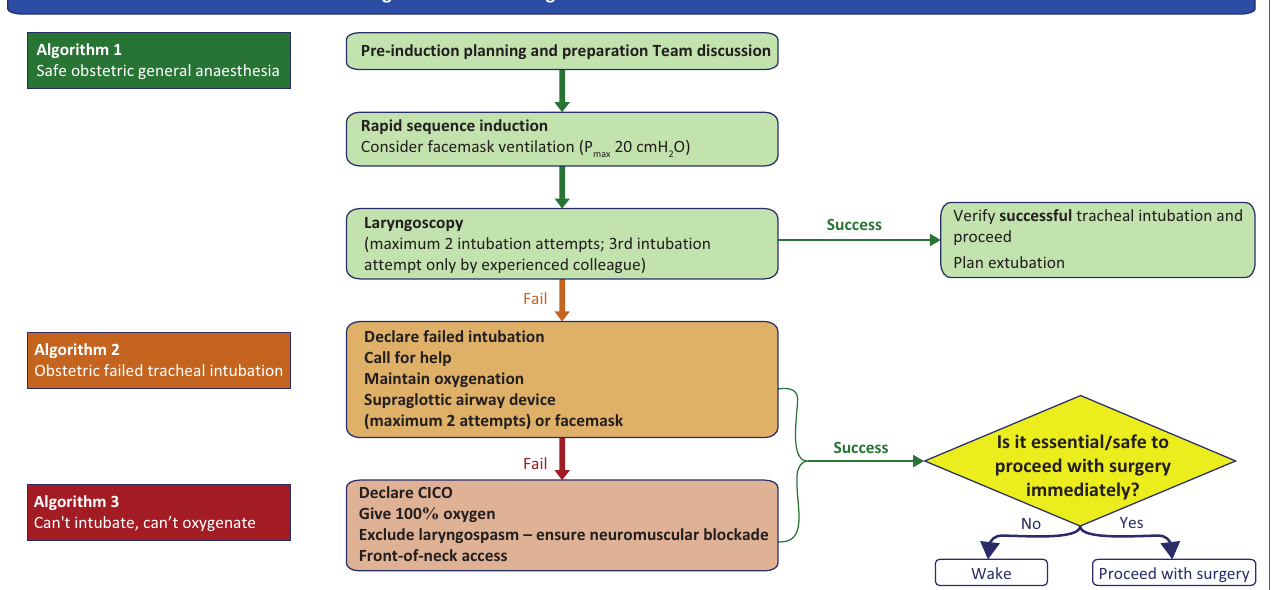
Master algorithm – obstetric general anaesthesia and failed tracheal intubation Algorithm 1 Safe obstetric general anaesthesia